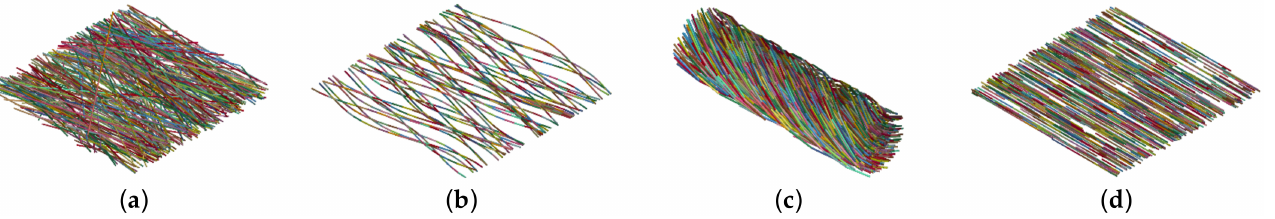
Figure 6. Modeled geometries with varying parameters: ( a ) orientation ( b ) waviness ( c ) twist ( d )